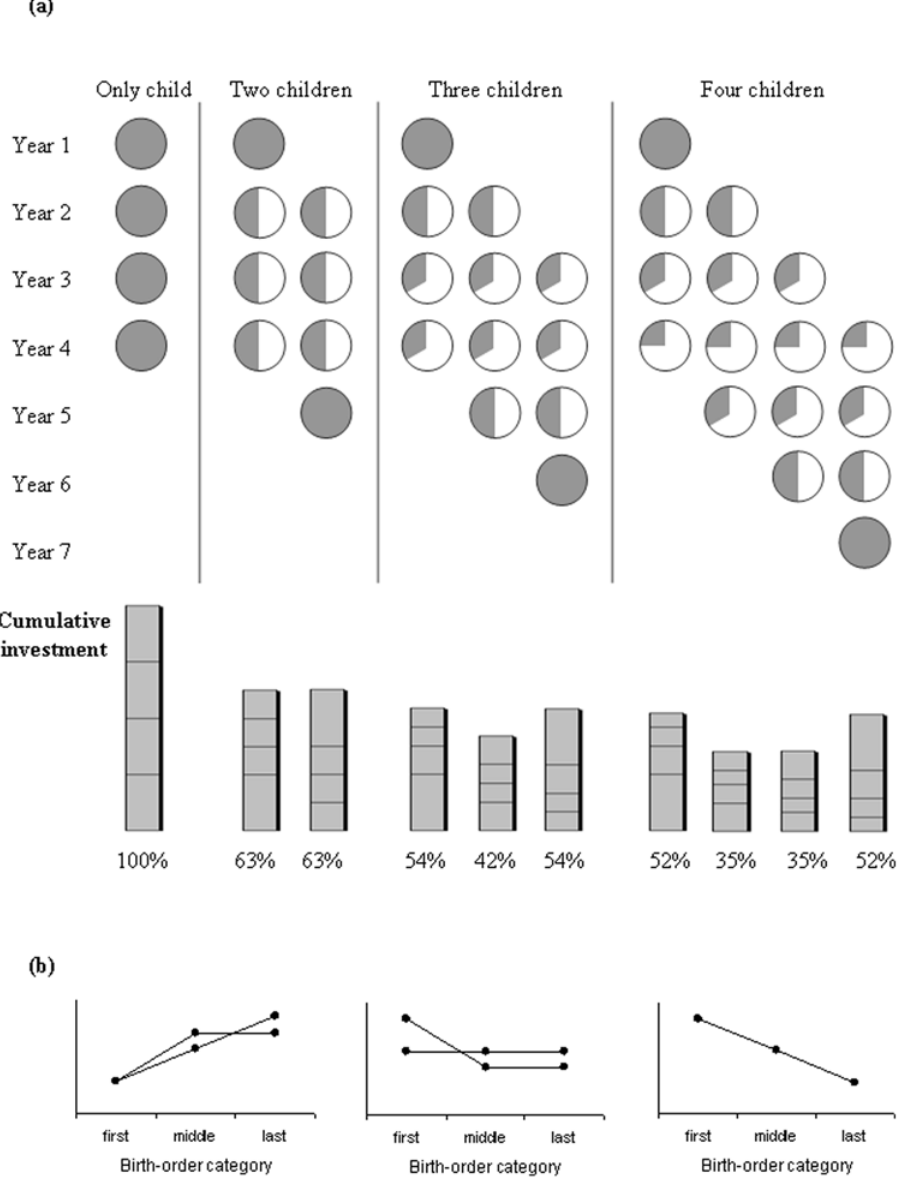
Figure 1. Alternative predictions regarding fitness effects of birth-order. (a) Resource allocation according to the equity heuristic as a function of birth rank in families with one to four children. Spheres in the upper part of the figure represent the proportion of resources obtained for a child in each of several birth ranks, in sibship sizes ranging from one to four, and across seven periods of growth (‘years’). The bars in the lower part show the cumulative resource distribution for children in an only-child, a two-child, a three-child and a four-child family. Whereas an equity motive produces a fair distribution at any given point in time, it yields a cumulative distribution of investments that is unequal. Adapted with permission from Hertwig, Davis & Sulloway (2002). (b) Fitness as a function of birth-order category (first-, middle- and last-borns): three example alternative predictions to that posited by Hertwig et al. (2002). Left panel: if parental experience is important for offspring success, or if parental investment increases as expected residual reproductive value decreases, all else being equal, middleborns and lastborns should be at an advantage. Middle panel: if parents favour firstborns (from which fitness benefits are likely to be greatest), a higher fitness is expected for firstborns compared with other categories; if parents favour middleborns which are likely to be at a competitive disadvantage, similar success is expected irrespective of birth-order category. Right panel: if resources diminish over time, lastborns are expected to be at a disadvantage.